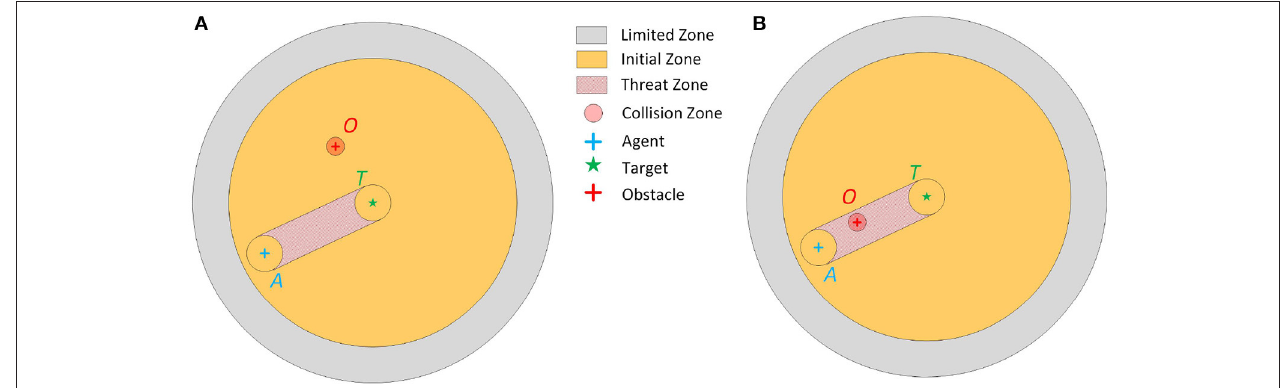
FIGURE 3 | (A) The episode mechanism of unit formation problem when the obstacle O is out of the threat zone. (B) The episode mechanism of unit formation problem when the obstacle O is in the threat zone.